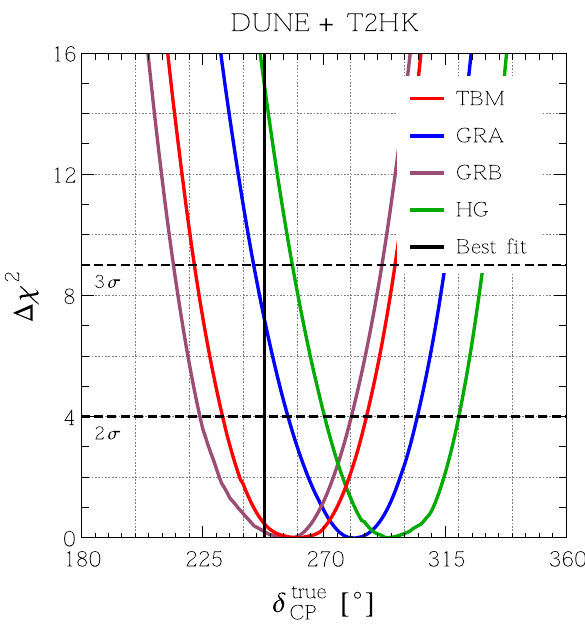
Fig. 2 Compatibility of the TBM, GRA, GRB, and HG symmetry forms with any potentially true value of the Dirac CPV phase δ CP . The figure is obtained employing combined potential of DUNE and T2HK. The black vertical line corresponds to the current best fit value of δ CP for the NO neutrino mass